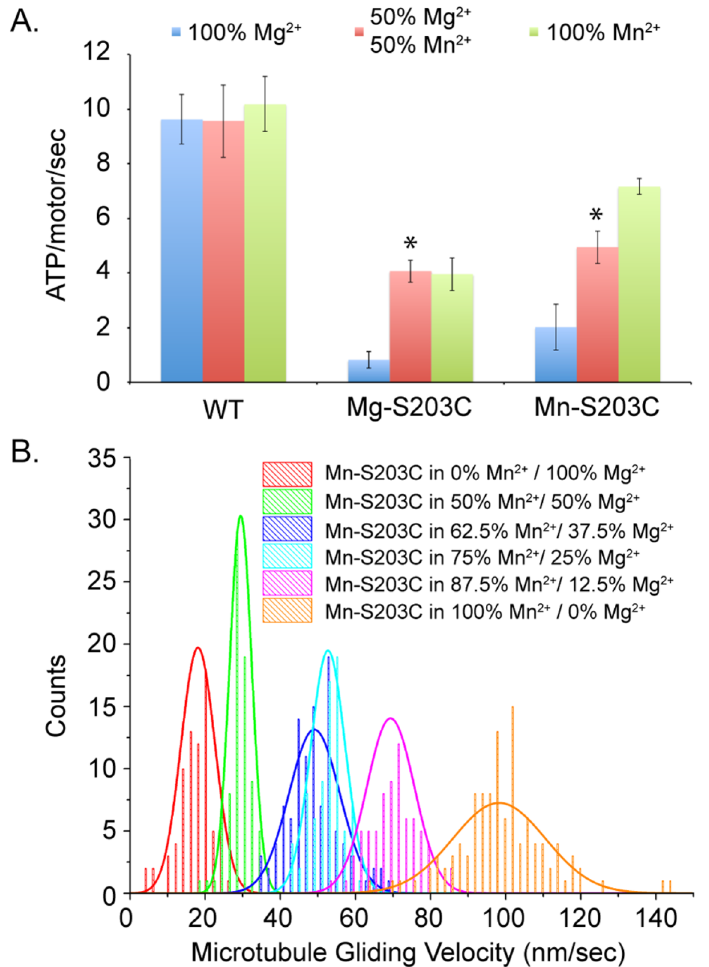
Fig 5. Mn 2+ -induced rescue of S203Cactivity. A) ATPase rate of WT, Mg-S203C, and Mn-S203C in buffers containingMg 2+ (100% Mg 2+ ), Mn 2+ (100% Mn 2+ ), or an equal ratio of Mg 2+ to Mn 2+ (50% Mg 2+ , 50% Mn 2+ ). The asterisk indicatesthat the ATPase rate in the 1:1 ratio of divalent cation is significantly greater than the rate in Mg 2+ alone (p < 0.01). B) Histogramswith Gaussianfits to the data of Mn-S203C in buffer conditions with the relative Mn 2+ :Mg 2+ ratios as